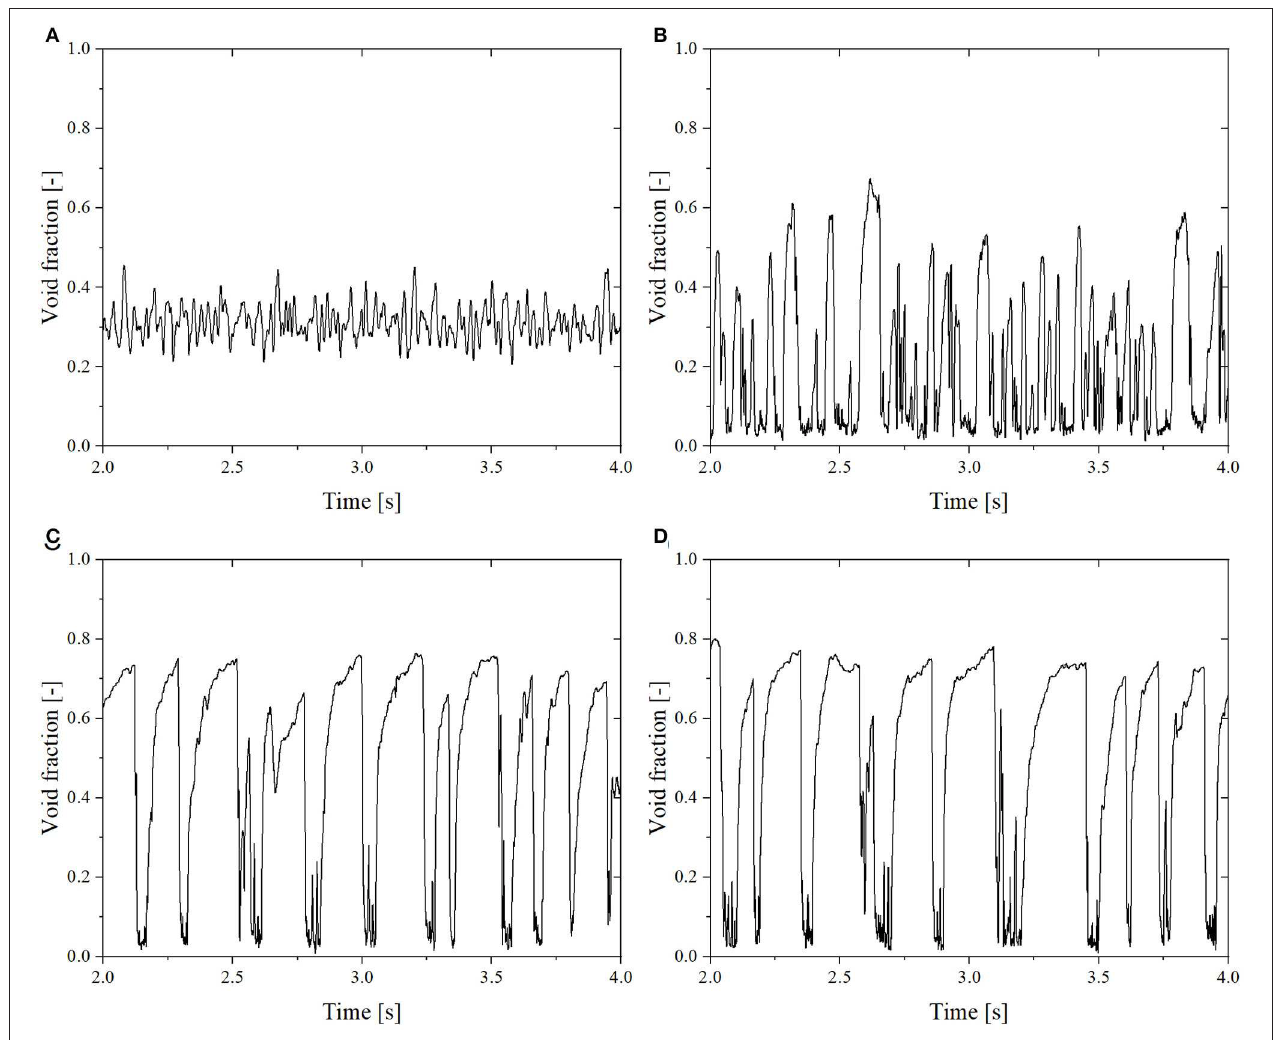
FIGURE 4 | Simulation data of void fraction for different integration time steps. (A) Time-step = 0.5ms. (B) Time-step = 0.2ms. (C) Time-step = 0.1ms. (D) Time-step = 0.05ms.